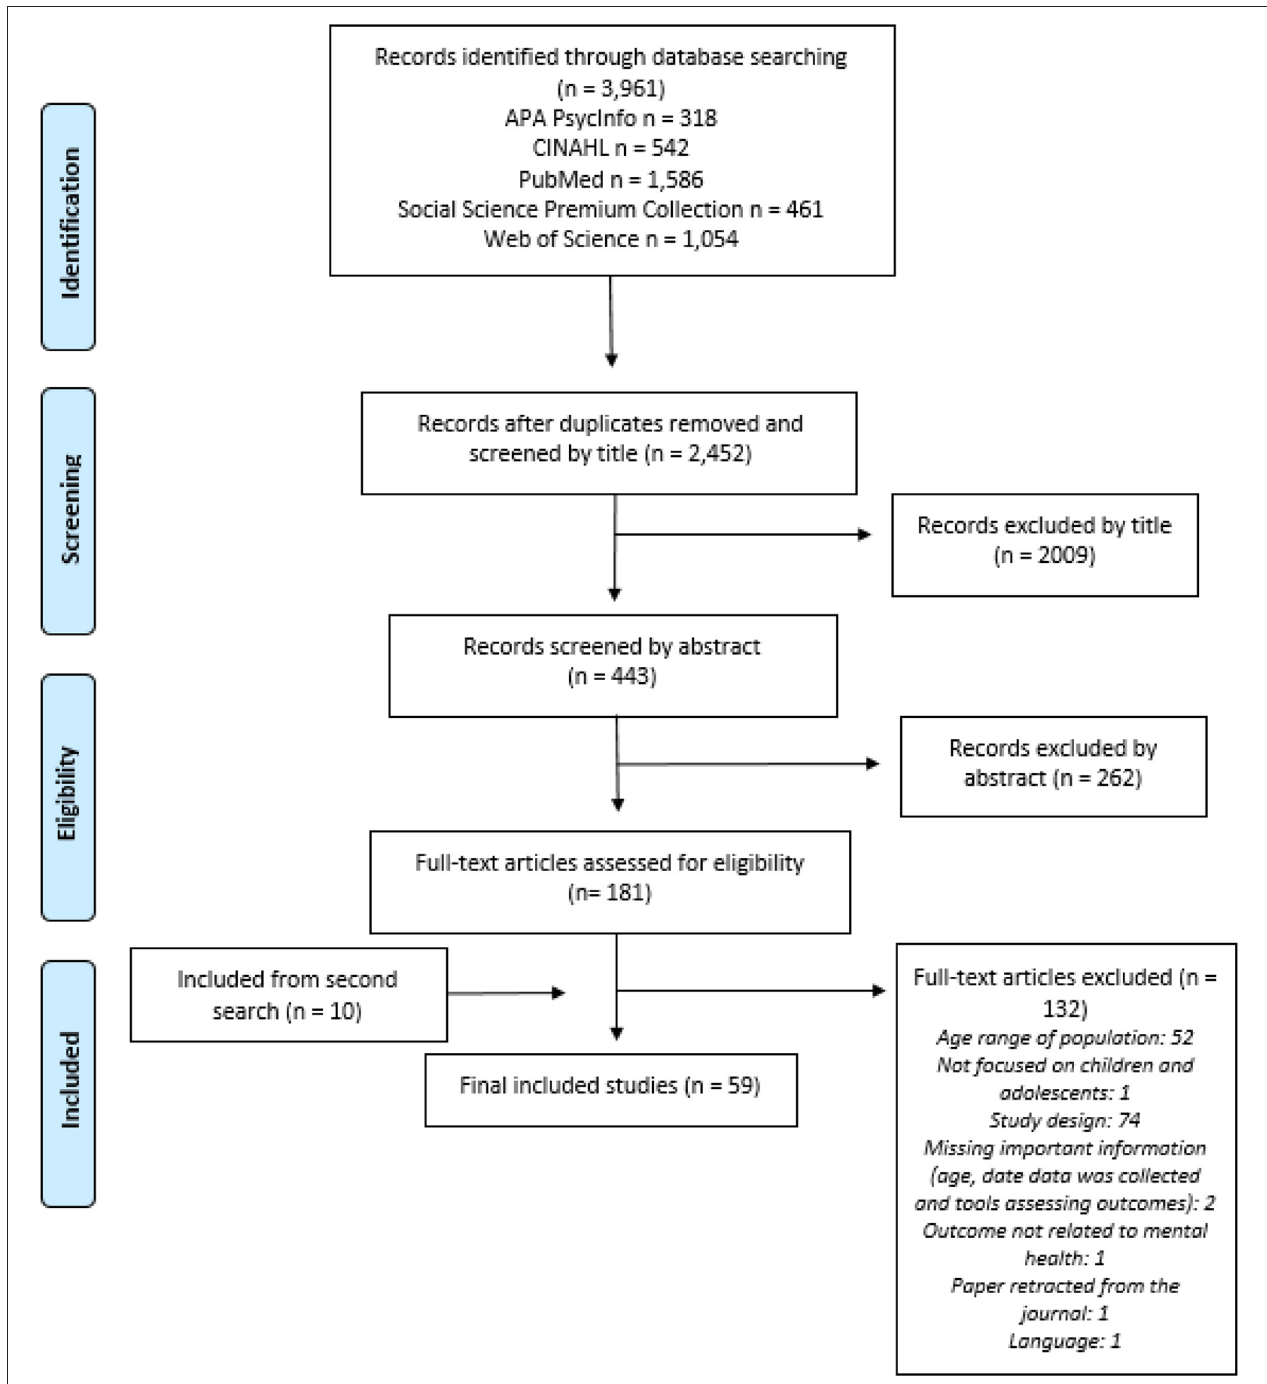
FIGURE 1 | Flow diagram of the selection